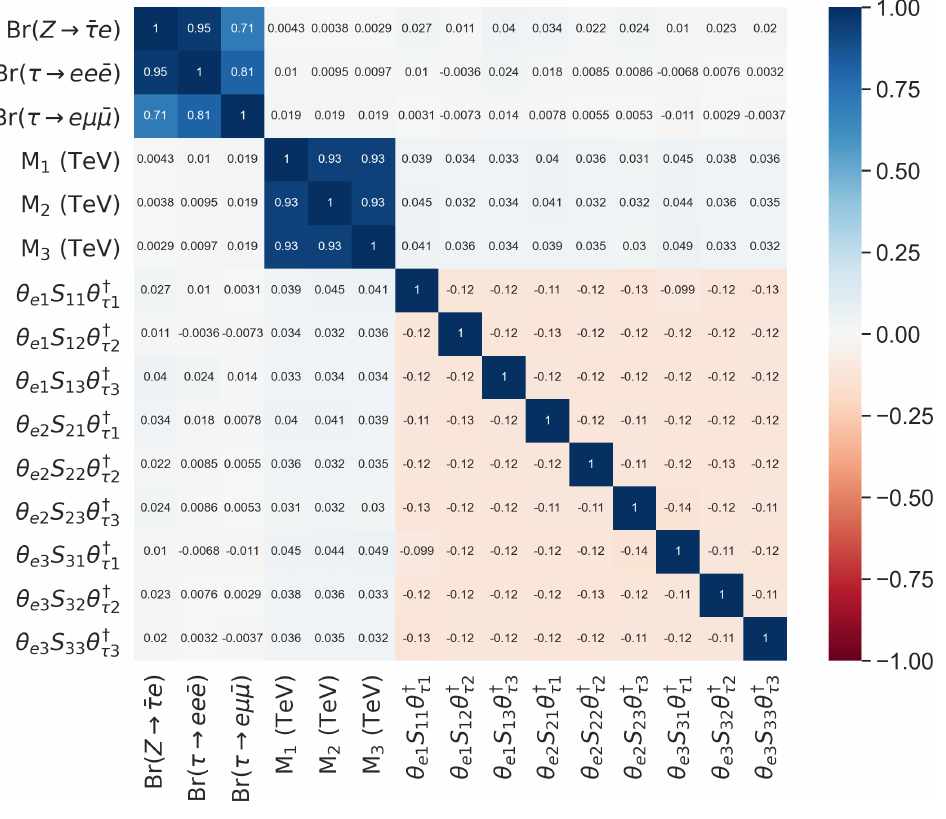
Figure 8 . Heat map that stands for the correlation matrix among ( θSθ † ) eτ − processes: Z → ¯ τe , τ → ee ¯ e , τ → eµ ¯ µ , and their free parameters.